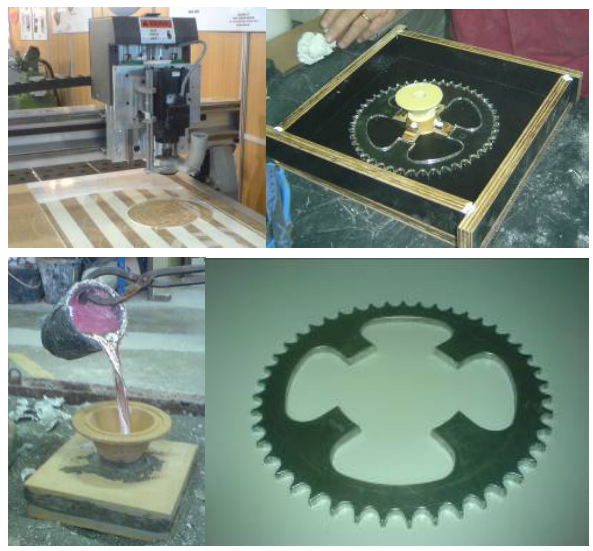
Figure 3. Ceramic block moulding to cast a duraluminium gear.